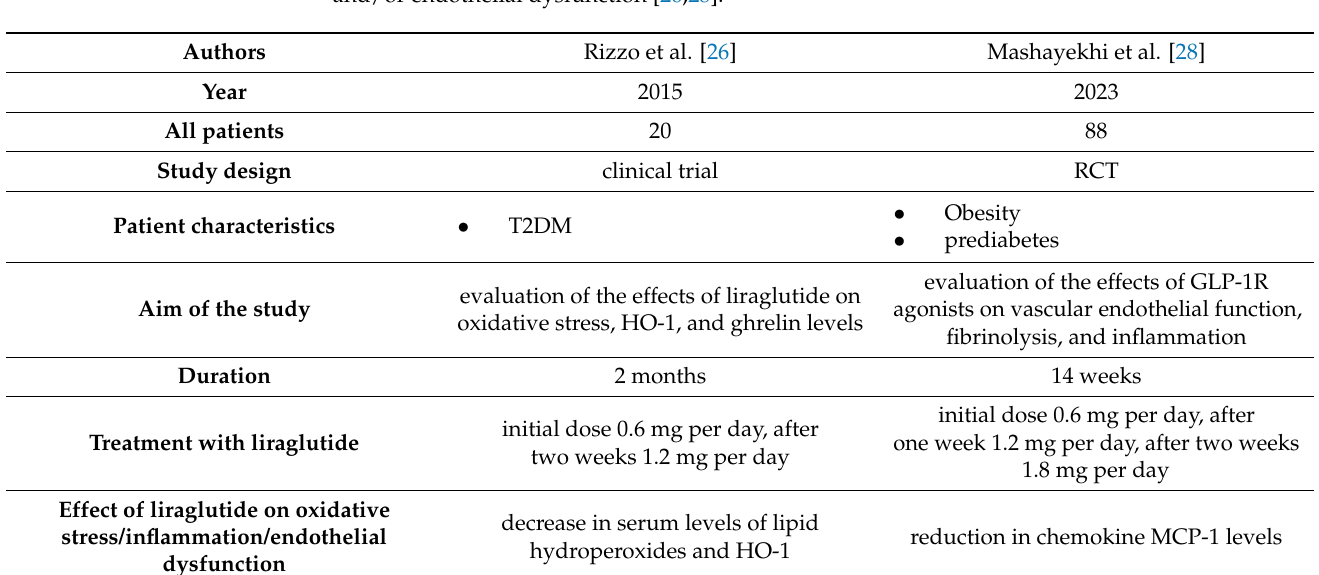
Table 3. Comparison of studies on the effect of liraglutide treatment on oxidative stress, inflammation, and/or endothelial dysfunction